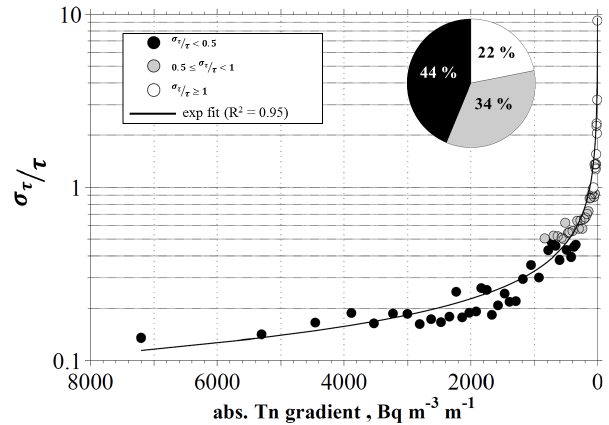
Fig. 11. Dependency of the relative uncertainty of the transport time ) on the absolute Tn gradient for the entire data set (51 days), ( σ τ τ including all inlet height arrangements (block 1–3) and heights ( z 1 , z 2 , z 3 ) . The data were sorted by the magnitude of the Tn gradient and averages of bins ( n = 50) were calculated before the exponen- tial fit was made. The pie diagram summarizes the fraction of τ values in each quality class (black: good, grey: adequate, white: in- adequate quality (for details see